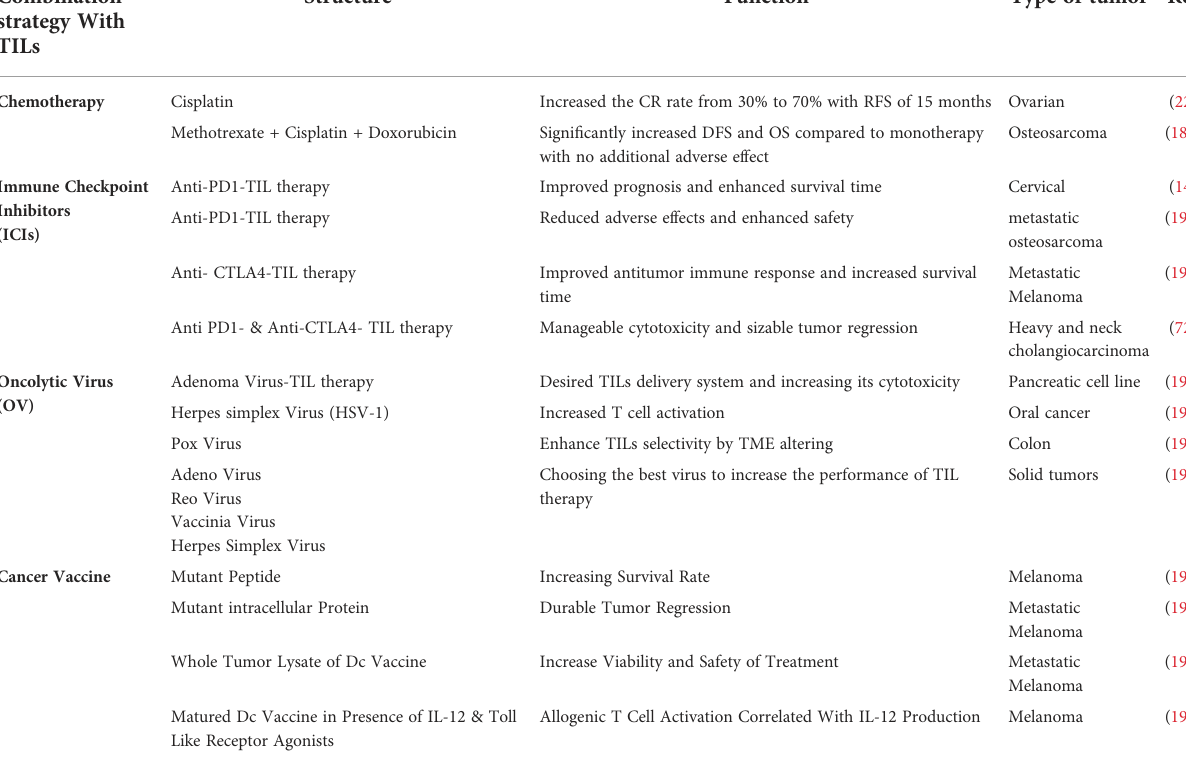
TABLE 2 The most important combination therapies with TILs. Combination strategy